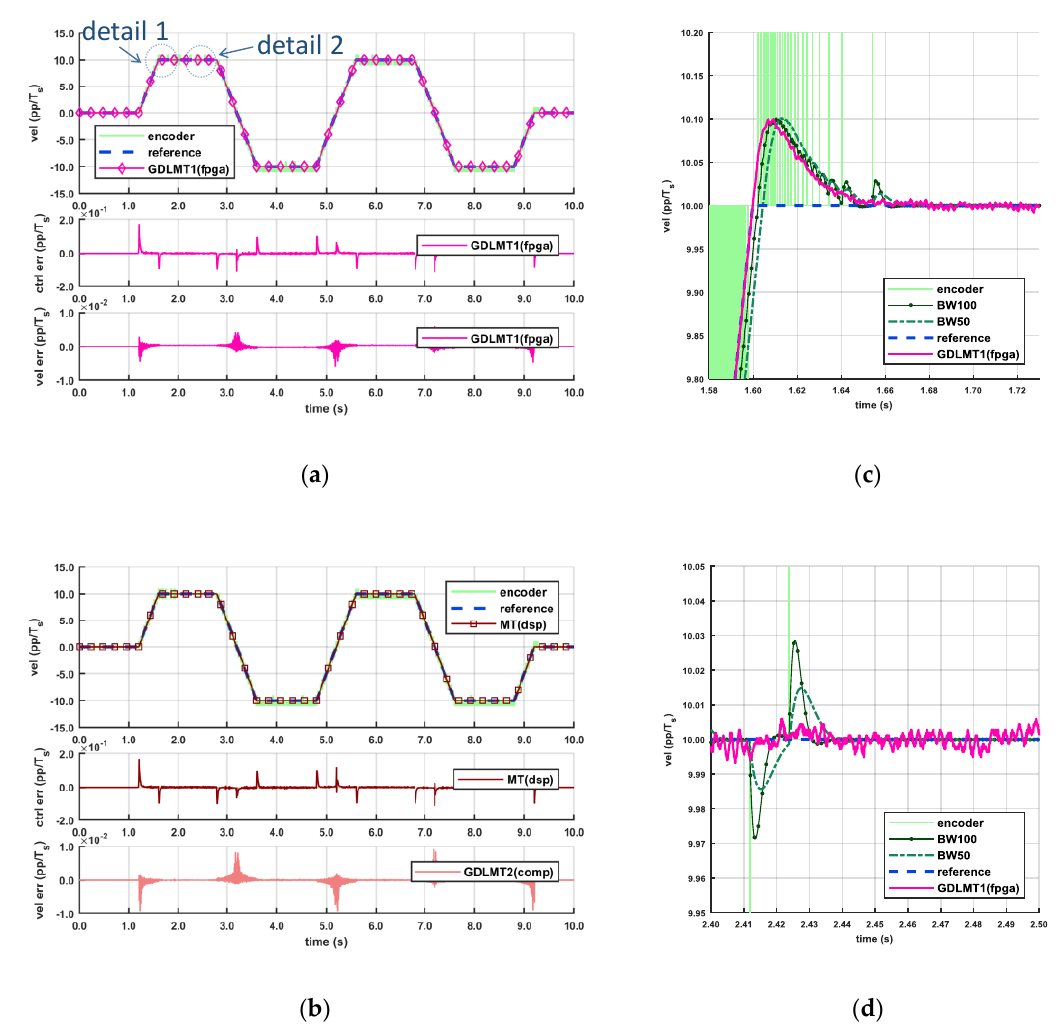
Figure 13. The motor experiment with the MT-type velocities: ( a ) The GDLMT1 velocity in feedback; ( b ) The MT velocity in feedback; ( c )–( d ) Details 1 and 2 from (a).